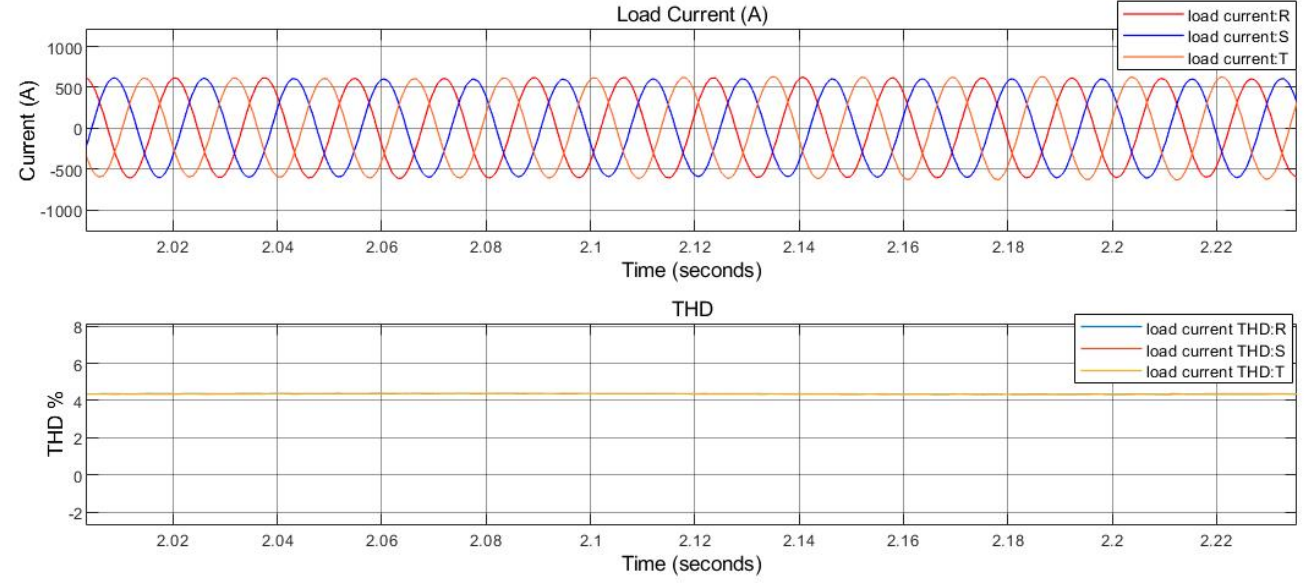
Figure 18. Load current and THD during simulation non ‐ linear load on the grid side using PWM.